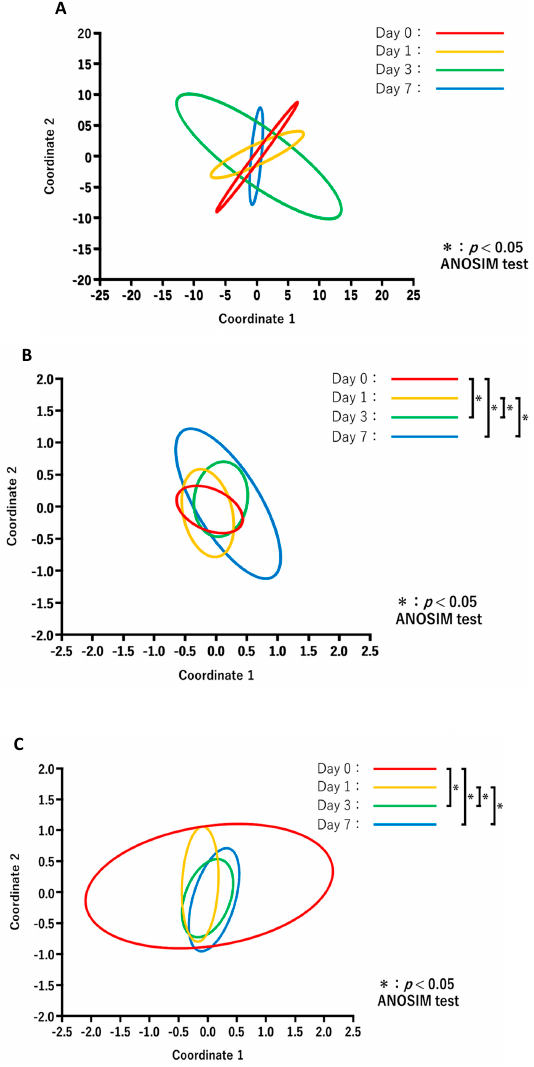
Figure 4. Principal coordinate analysis and ANOSIM test based on the Bray–Curtis distances and comparing the microbiome data of day 0, 1, 3 and 7 in each treatment of NT-NT group ( A ), NT-AMT group ( B ) and AMT-AMT group ( C ). ( A ) Comparison of the diversity between the days after treatment in the NT-NT group. There were no significant differences between the days after treatment. ( B ) Comparison of the diversity between the days after treatment in the NT-AMT group. There were significant differences between days 0 and 3, days 0 and 7, days 1 and 3 and days 1 and 7. ( C ) Comparison of the diversity between the days after treatment in the AMT-AMT group.